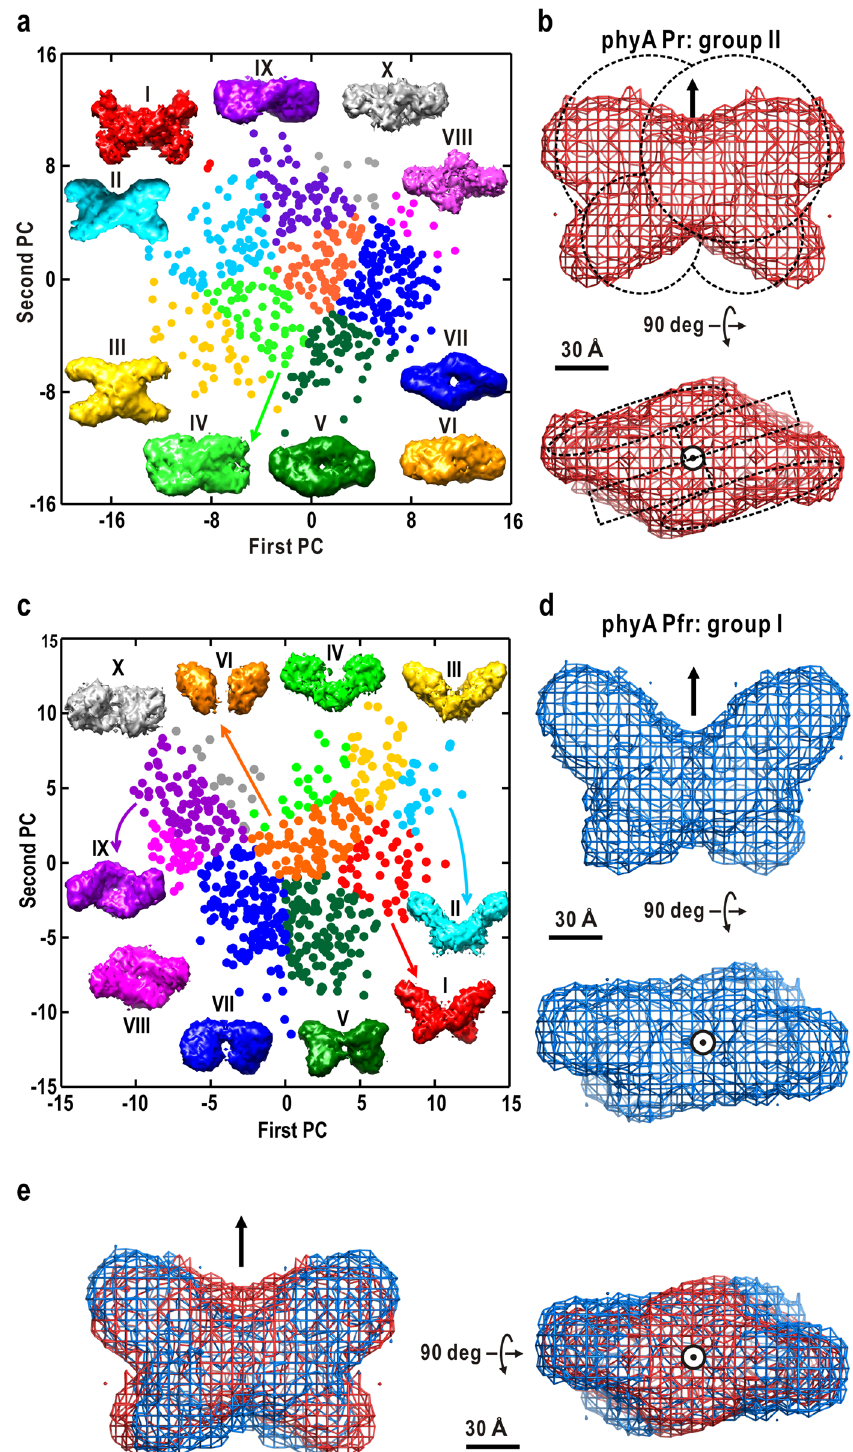
Figure 3. Selection of the most probable molecular shape of the Pr dimer ( a , b ) and Pfr dimer ( c , d ). In panels ( a , c ), 560 models from independent ab initio calculations are plotted on the plane spanned by the first and second eigenvectors from PCA. Through K-means clustering, the models were classified into 10 groups designated I-X. The number of the Pr models classified into groups I-X are 2, 75, 43, 59, 73, 77, 142, 10, 70, and 9, respectively. On the other hand, those of the Pfr models in groups I-X are 45, 23, 38, 23, 116, 84, 150, 41, 79, and 15, respectively. The molecular shape of each group was obtained by averaging the DR models after superimposition on a reference structure. The averaged shape for each group was illustrated using UCSF Chimera 57,58 . Panels ( b , d ) show averaged shapes for group II of Pr and group I of Pfr, respectively. The representing shapes are shown as mesh models with arrows and symbols representing the two-fold symmetry axes. In panel ( b ), the four-leaf shaped model (dashed lines) in the early stage of our SAXS study 38 is superimposed. ( e ) Superimposition of averaged molecular shapes of Pr (red mesh) and Pfr